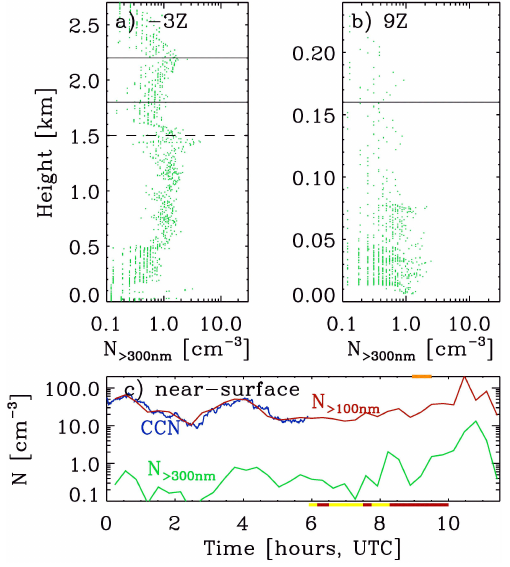
Fig. 11. Near-surface and helicopter aerosol measurements on 25 August 2008 (Case #3), including helicopter profiles of aerosol con- centration for particles larger than 300nm taken (a) about 3h prior to 0Z and (b) 9z, and (c) concentrations of CCN (blue), aerosols larger than 100nm (red) and aerosols larger than 300nm (green) measured onboard Oden . In (a–b) , the solid and dashed lines are the cloud boundaries and mixed-layer base heights determined by remote sensors at the time, respectively. Red bars on the lower axis of (c) indicate questionable data due to contamination (yellow bars may also be questionable due to temporal proximity), while the or- ange bar on the top axis shows the time of the second helicopter profile. Note the different vertical scales for (a) and (b)